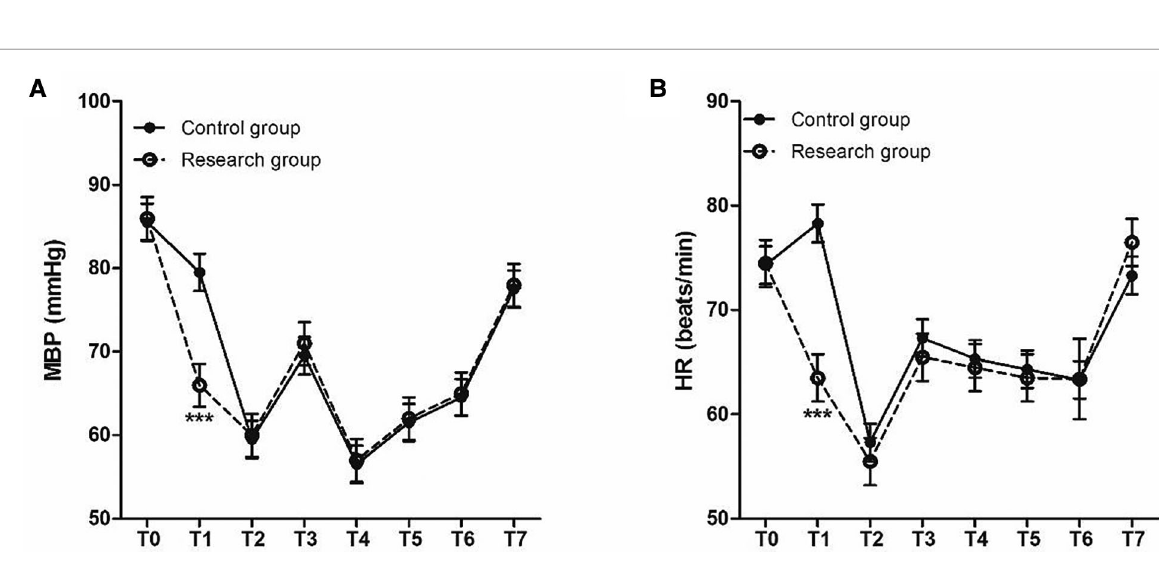
FIGURE 3 Perioperative HR and MBP at different time points. ( A ) MBP (mmHg) and ( B ) HR (beats/min). T0, baseline; T1, time after loading dose; T2, induction; T3, intubation; T4 – T6, 30, 60, and 90 min after intubation; T7, 24 h after